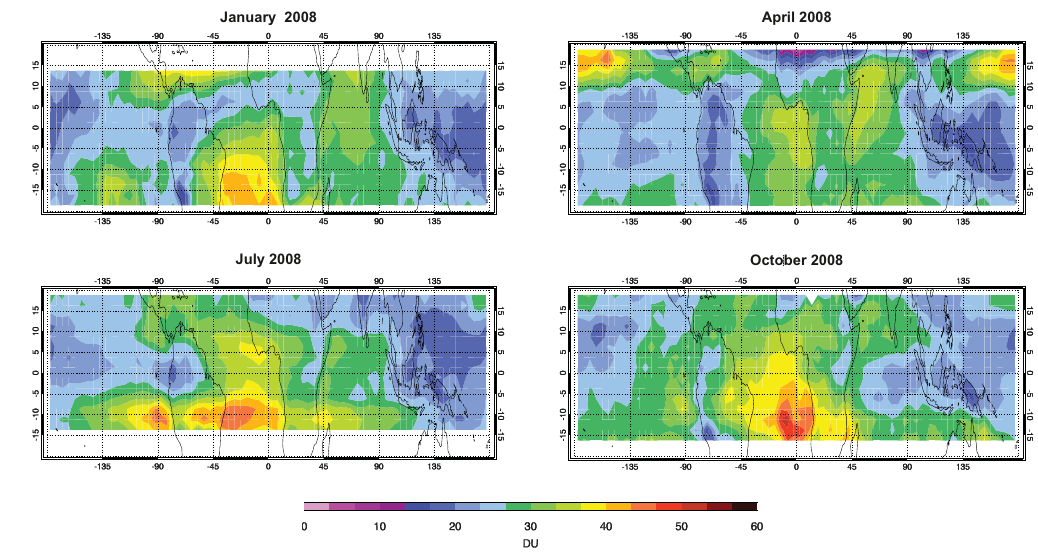
Figure 11. Tropical tropospheric ozone column (TTCO) derived with the convective cloud differential (CCD) technique for January, April, July, and October 2008 using GOME-2